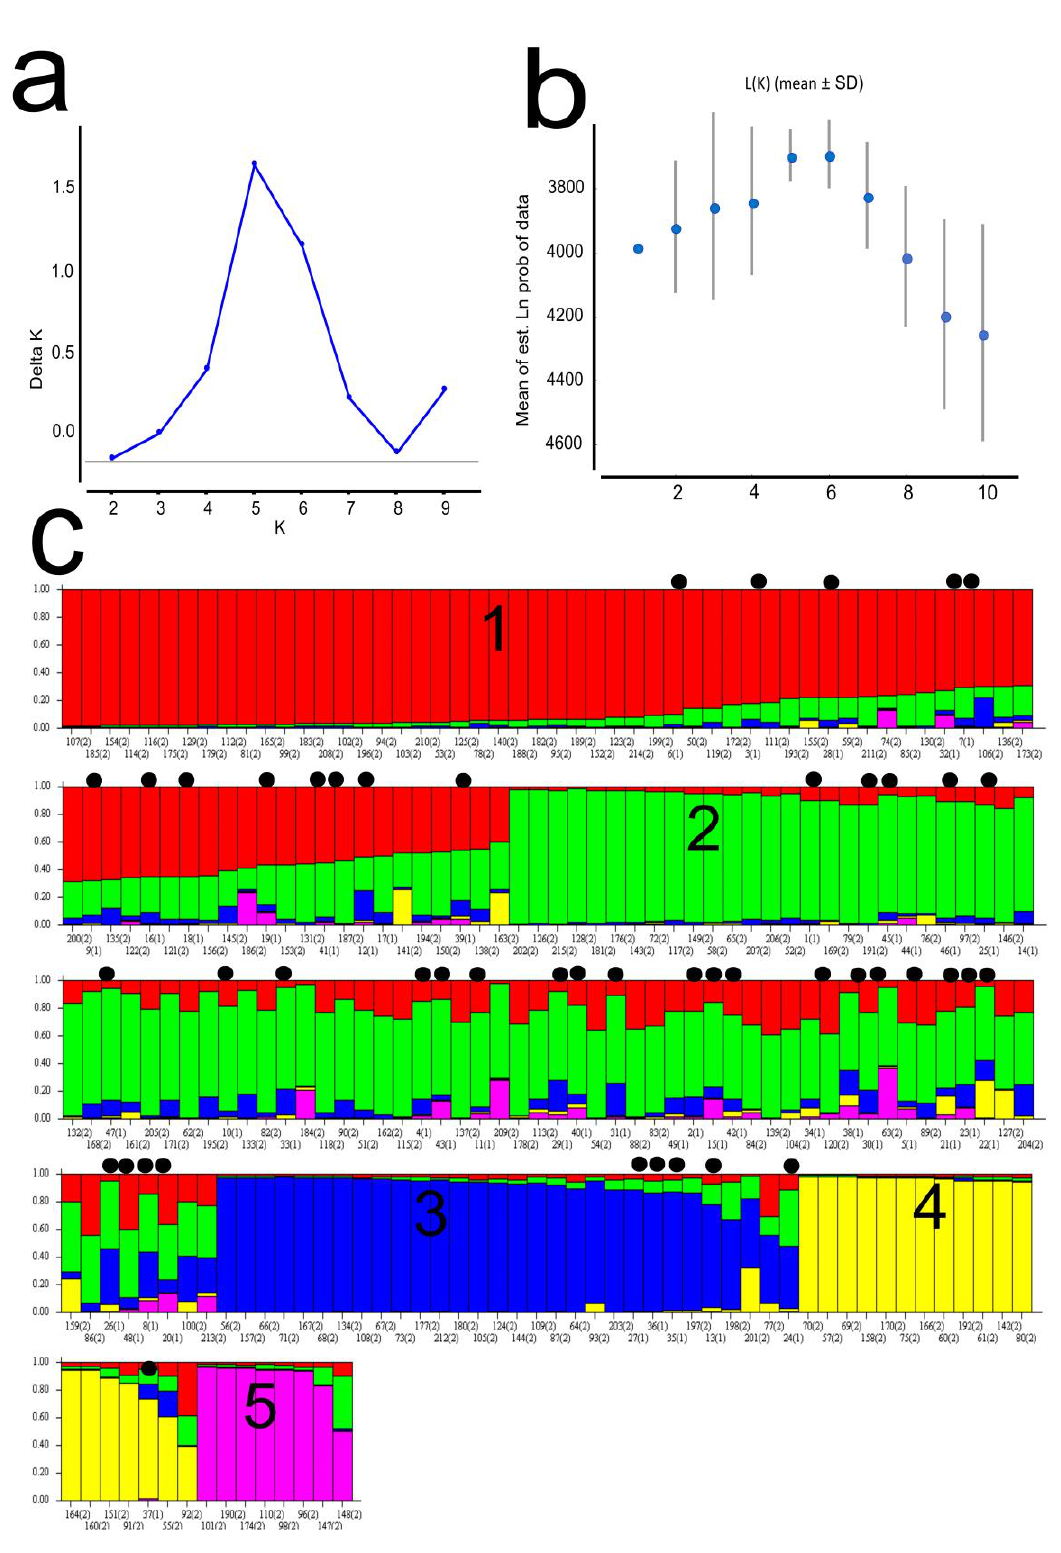
Figure 2. ( a ) Mean ln P (K) graph, ( b ) Evannos Δ K graph, ( c ) Q-membership proportion of K = 5 genetic clusters of founders (black dots), and breeding individuals of the Xcaret Mesoamerican scarlet macaw ( Ara macao cyanoptera ) based in six microsatellites markers. The length of the colored segment indicates the proportion of the individual’s composition in specific clusters showing admixture in the population.